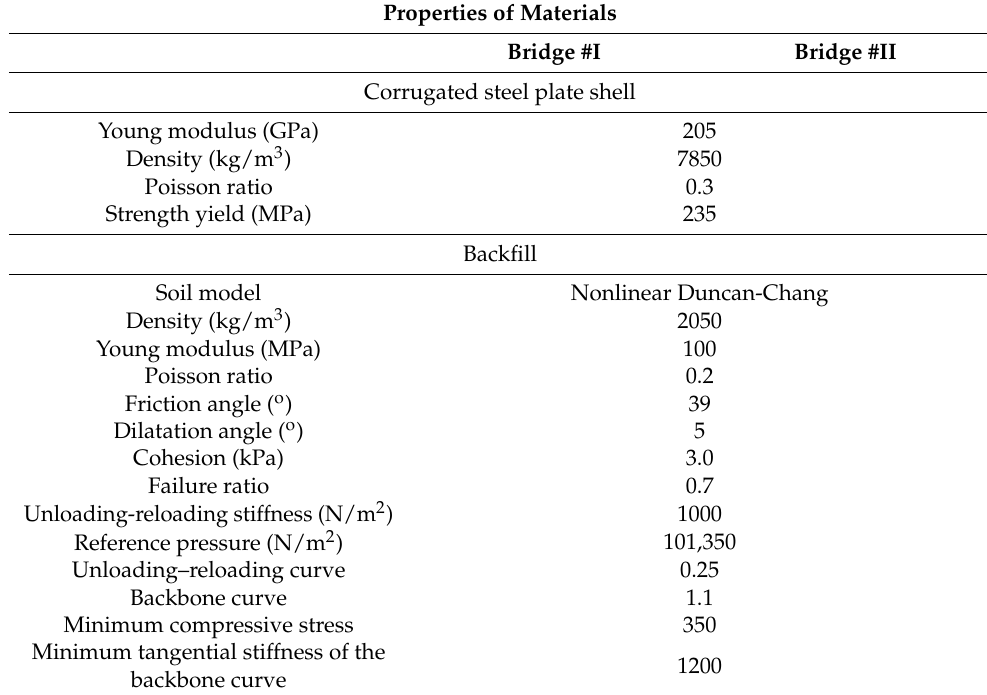
Table 1. Material properties of soil–steel composite bridges.